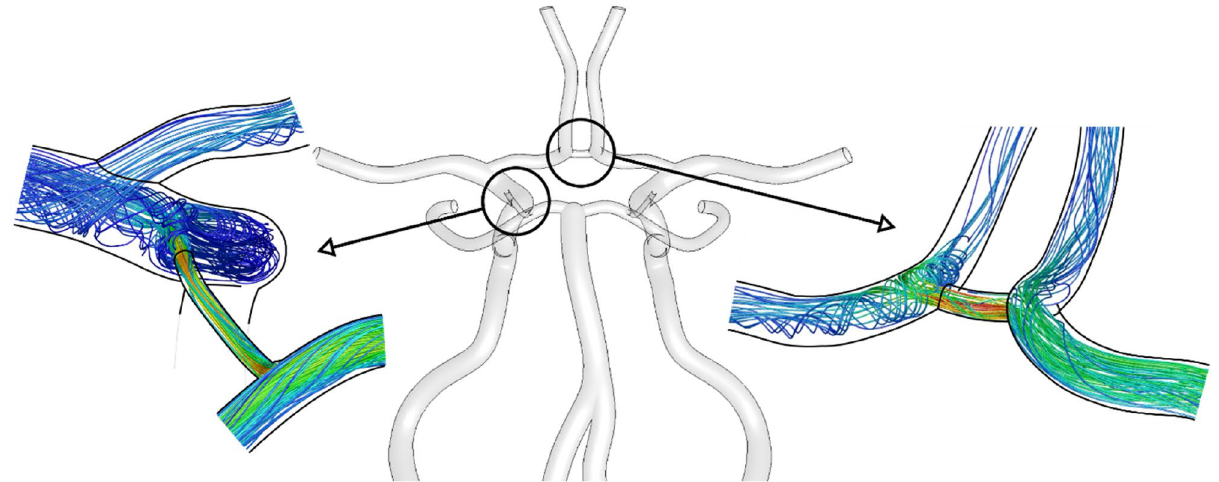
Figure 4. Streamlines showing the additional recirculation areas and impinging jets in junctions.